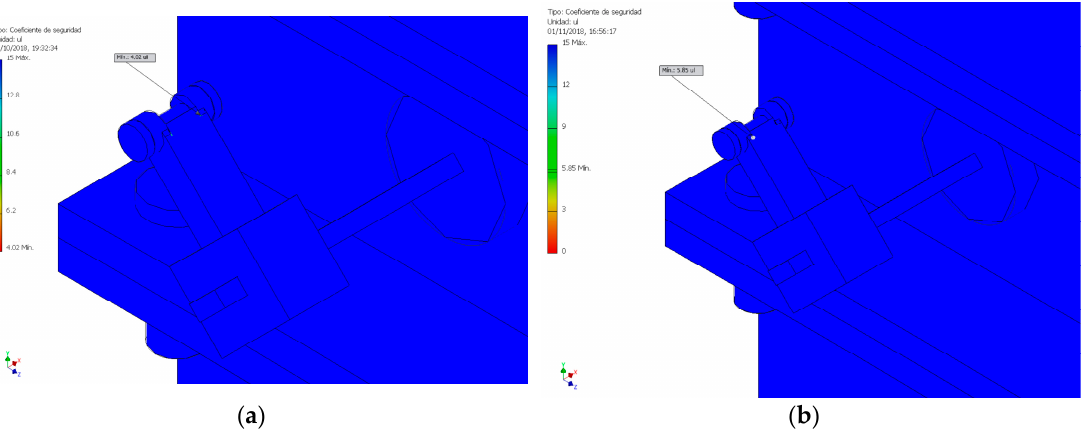
Figure 18. Location of the lowest safety coefficient: ( a ) downward movement and ( b ) upward movement.